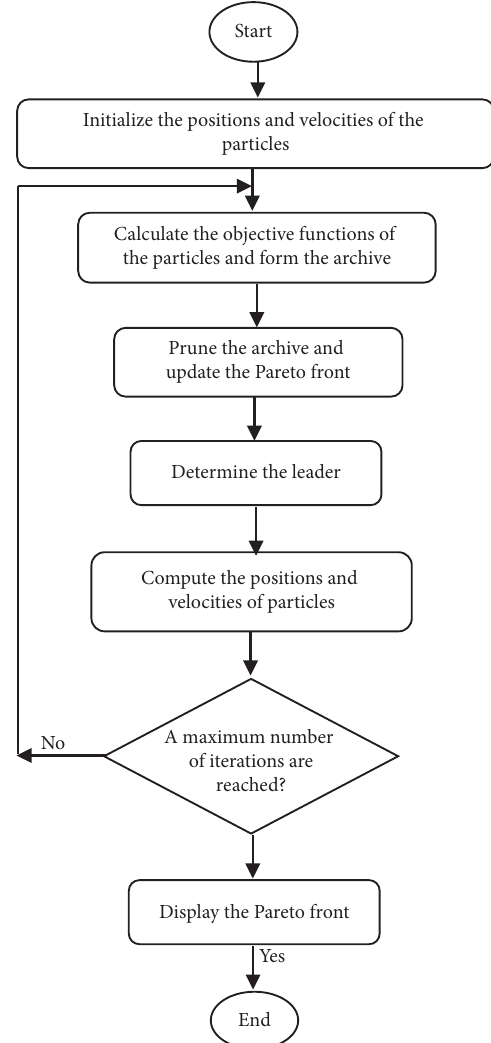
Figure 3: Flowchart of the considered multiobjective optimization